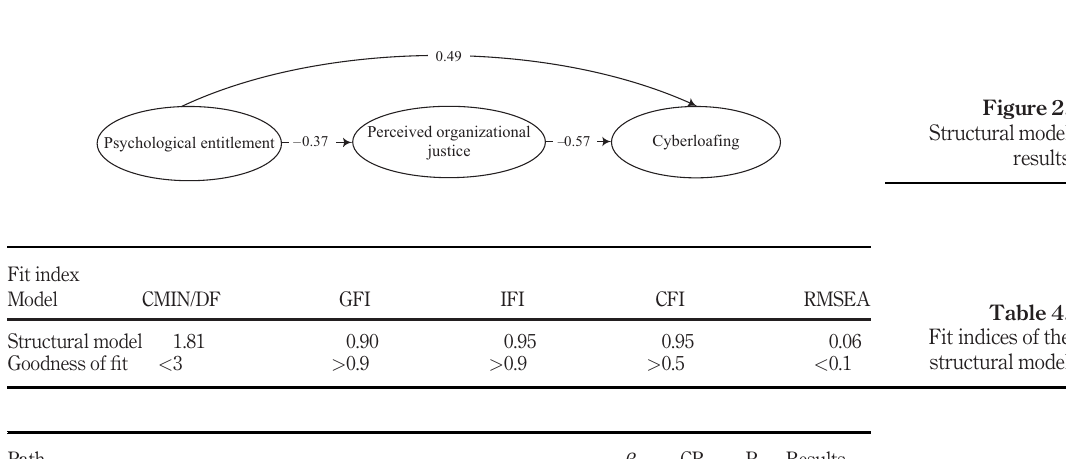
Figure 2. Structural model